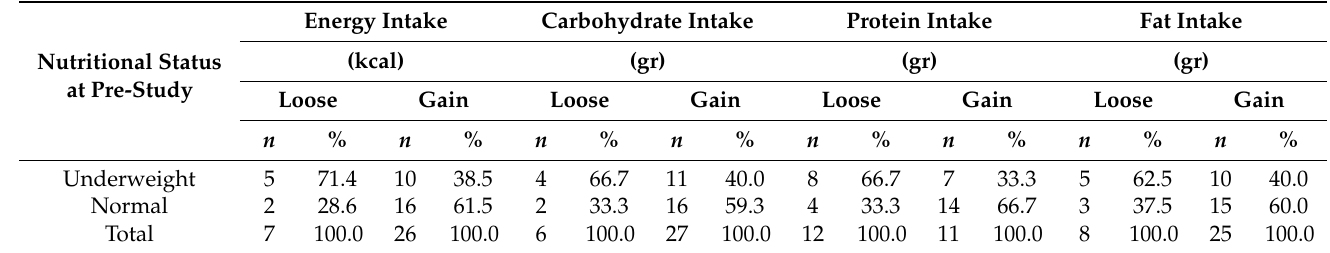
Table 6. Anthropometry, macronutrient intakes, and nutrition and natural disaster preparedness of